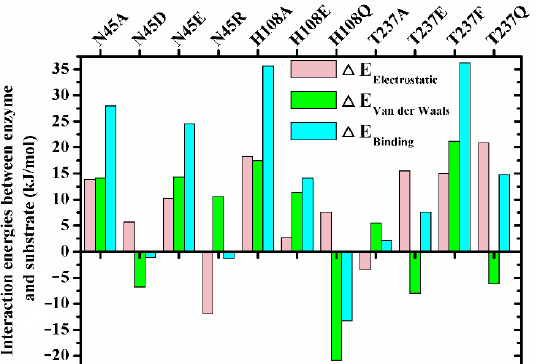
Figure 4. The interaction energies between enzymes and TC during the simulations. ∆E X = E XMutant − E XWild−type , where E X represents electrostatic, van der Waals or binding energy obtained from the balanced phase of corresponding simulations (E binding = E electrostatic + E van der Waals ).